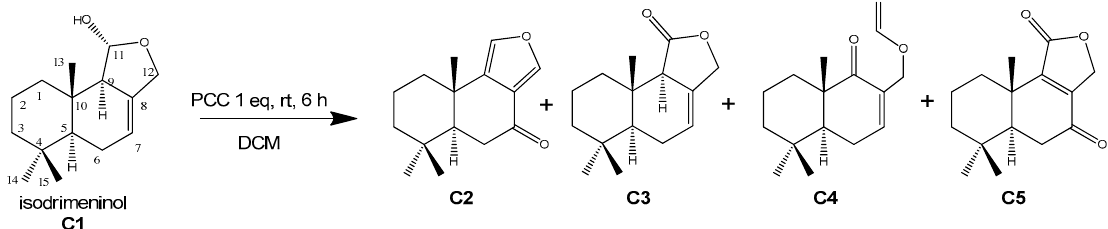
Scheme 1. Molecular structures of drimane derivatives obtained by PCC oxidation of isodrimeninol. Compounds C2 , C3 , C4 , and C5 were characterized by 1D and 2D NMR spectroscopy. 1 H-NMR and 13 C-NMR results are summarized in the Tables 1 and Table 1. 1 H-NMR (600 MHz, in CDCl 3. δ in ppm. J in Hz) results for sesquiterpenoids.